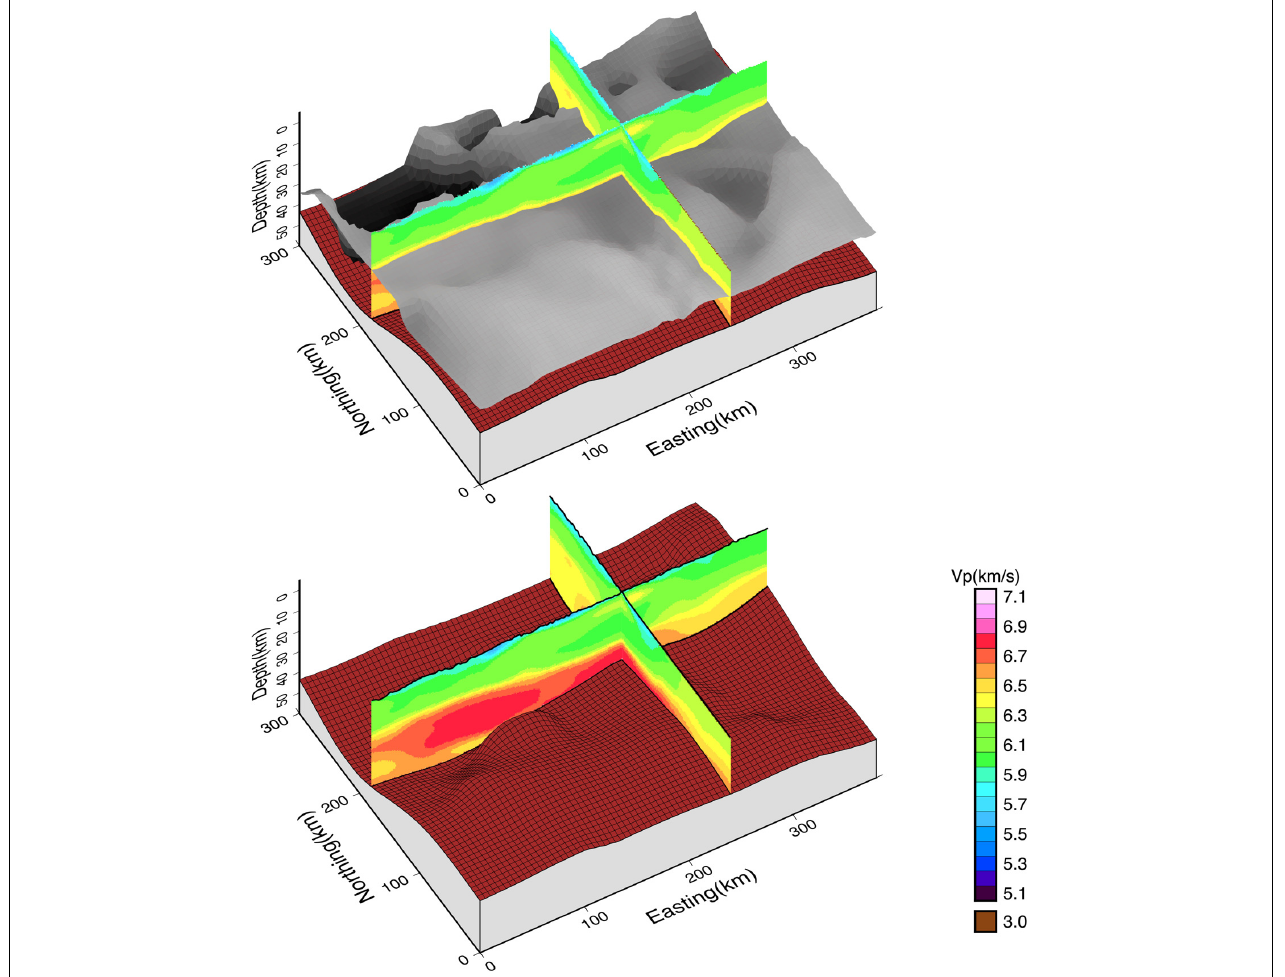
FIGURE 7 | V P values of the 3D NAC model. Two vertical sections (one in X-direction at y = 200 km, the other in Y-direction at x = 240 km) and two surfaces (isosurface for V P = 6.4 km/s-gray scale and Moho-brown) are